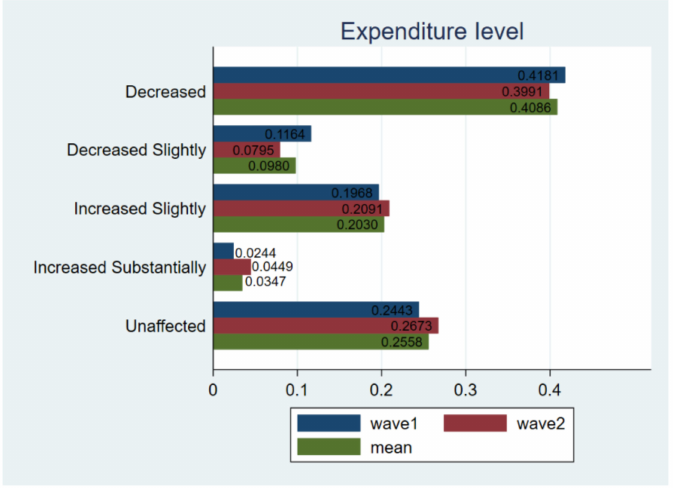
Comparing expenditure level. Notes: t -test for H 0 : equal variance assumed: